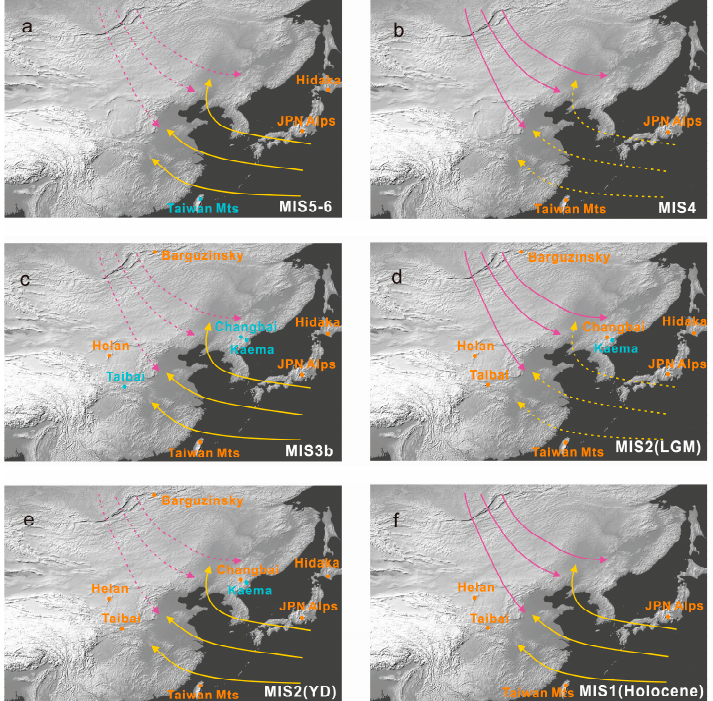
Figure 5. The responses of mountains in the EAM region to monsoonal circulations during different glacial stages. The EAWM purple and the EASM yellow, the orange words indicate the exact mountains that experienced glaciations, the blue words indicate the mountains that experienced assumed glacial advances. Purple lines represent the EAWM, yellow lines represent the EASM, dashed and solid lines indicate EAM strength. ( a ) EASM enhanced and EAWA weakened climate model MIS6 − 5. ( b ) EASM weakened and EAWM enhanced climate model MIS4. ( c ) EASM enhanced and EAWA weakened climate model MIS3b. ( d ) EASM weakened and EAWM enhanced climate model MIS2–LGM. ( e ) EASM enhanced and EAWM weakened climate model YD. ( f ) EAWM and EASM enhanced climate model Holocene MIS1.